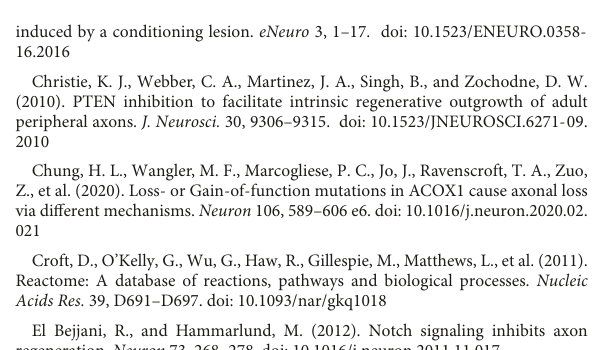
SUPPLEMENTARYTABLE3 List of predicted correlations between circular RNAs, microRNAs, and